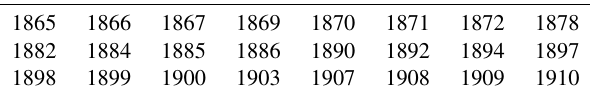
Table B4. Years above or at the median of SPEI (wetter conditions) during the years